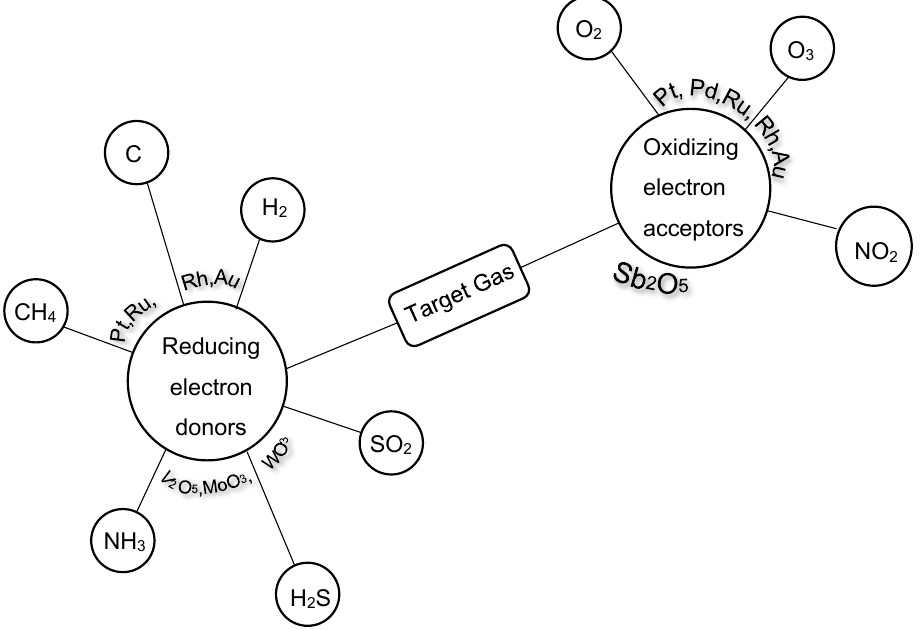
Figure 2. Oxide thin-films with various properties in the application of the waste-gas treatment field. Left part: Reducing gasses’ electron donors to make the waste-gas harmless through the ion-exchange membrane; Right part: Oxidizing gases’ electron acceptors to make the waste-gas harmless through oxidation catalysis.